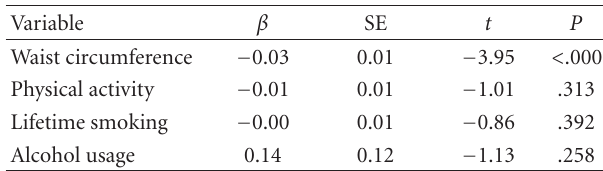
Table 3: Summary of multiple regression analysis for all health behaviours predicting brachial artery reactivity, controlling for age, sex, CVD status, ace inhibitor use, statin use, hypertension, diabetes, and hypercholesterolemia.